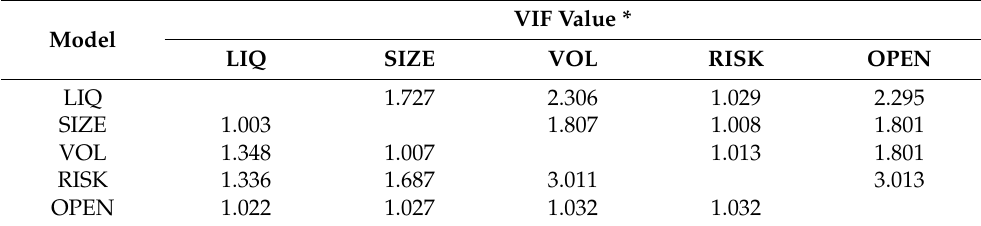
Table 5. Multicollinearity test results, authors source.